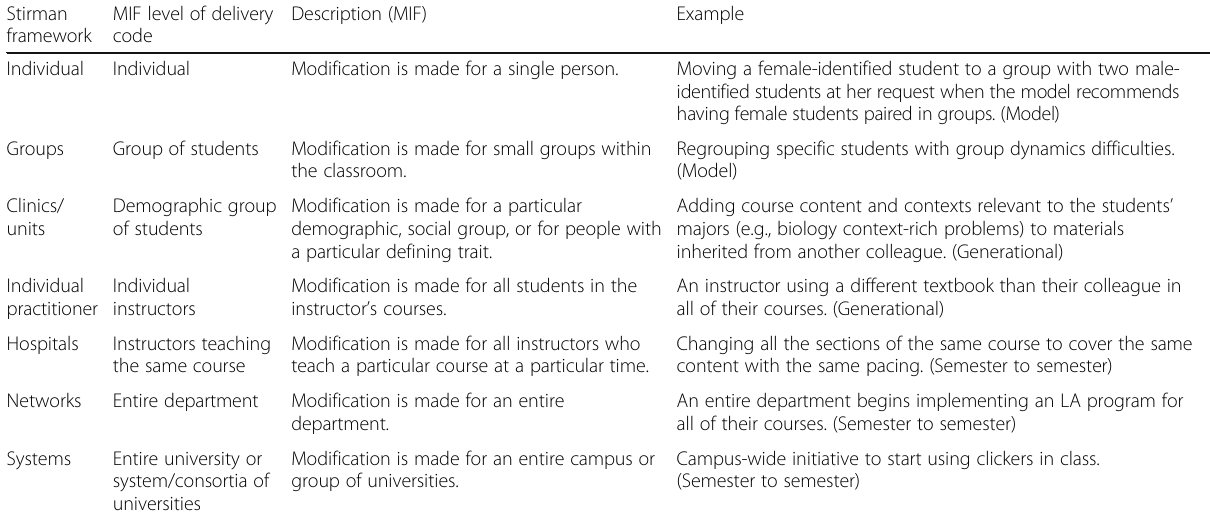
Table 3 Instructional practice changes — level of delivery codes Stirman MIF level of delivery framework